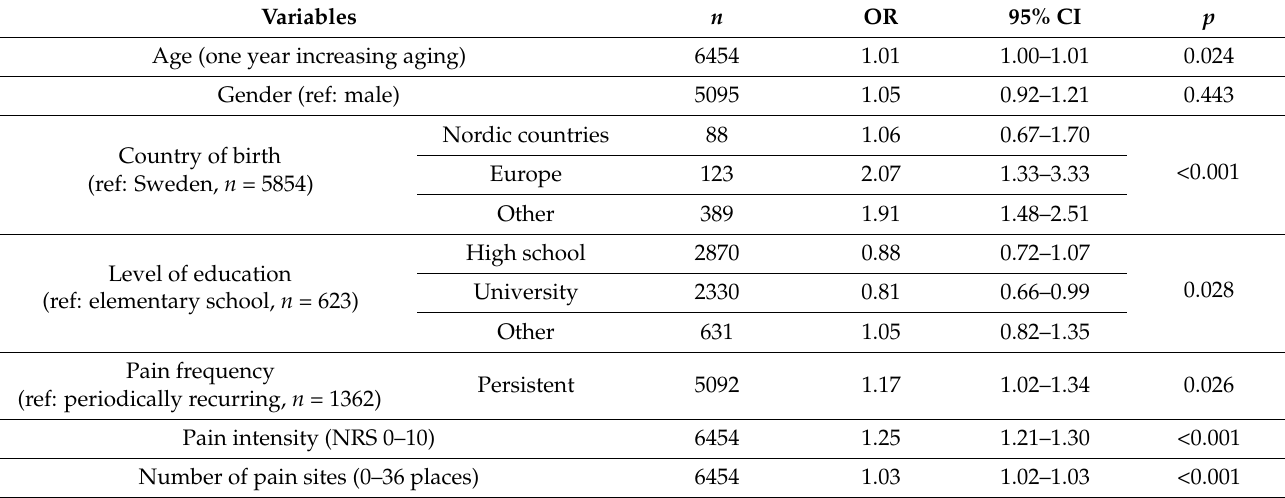
Table 3. Logistic regression analysis of the study group at baseline ( n = 8515) with clinical insomnia as dependent binary variable (clinical insomnia: ISI >14). Sociodemographic variables and pain characteristic factors were used as independent variables after checking for possible collinearity. OR = odds ratio, 95% CI = 95% confidence interval, NRS = numeric rating scale.